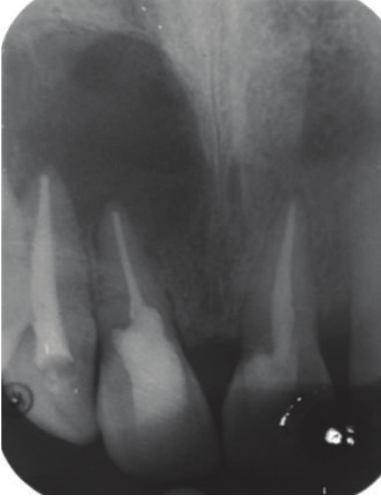
Figure 19: 1-month followup IOPA radiograph.